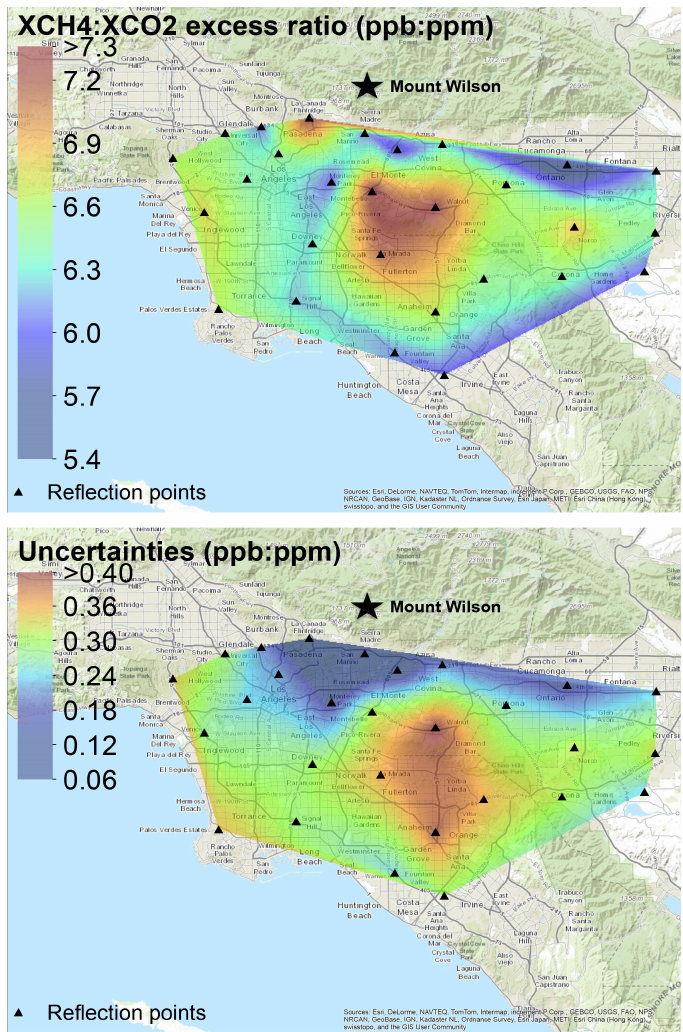
Figure 5. Maps of correlation slopes of the XCH 4 ( XS ) :XCO 2 ( XS ) ratio (top) and their uncertainties (1 standard deviation) (bottom) in the Los Angeles megacity observed by the CLARS-FTS during the period of September 2011 and October